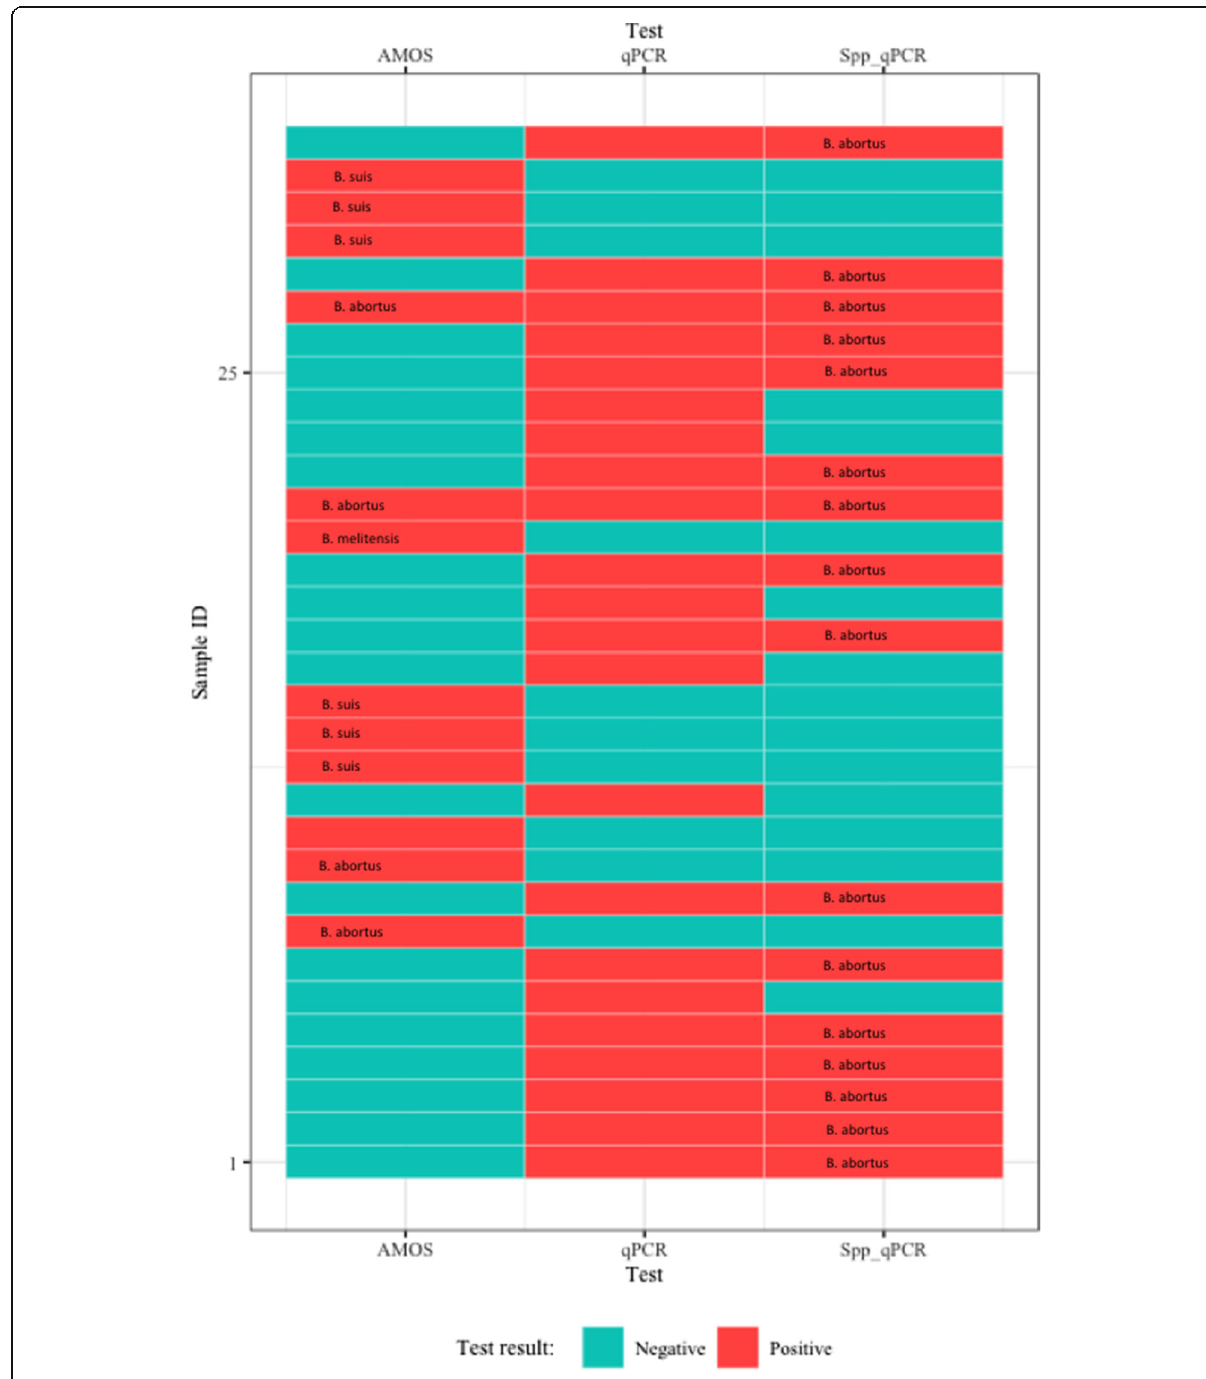
Fig. 2 Schematic aggregate plot for the samples tested positive for the three assays (AMOS PCR, qPCR genus specific and species specific), Brucella spp. identified and the respective agreement across